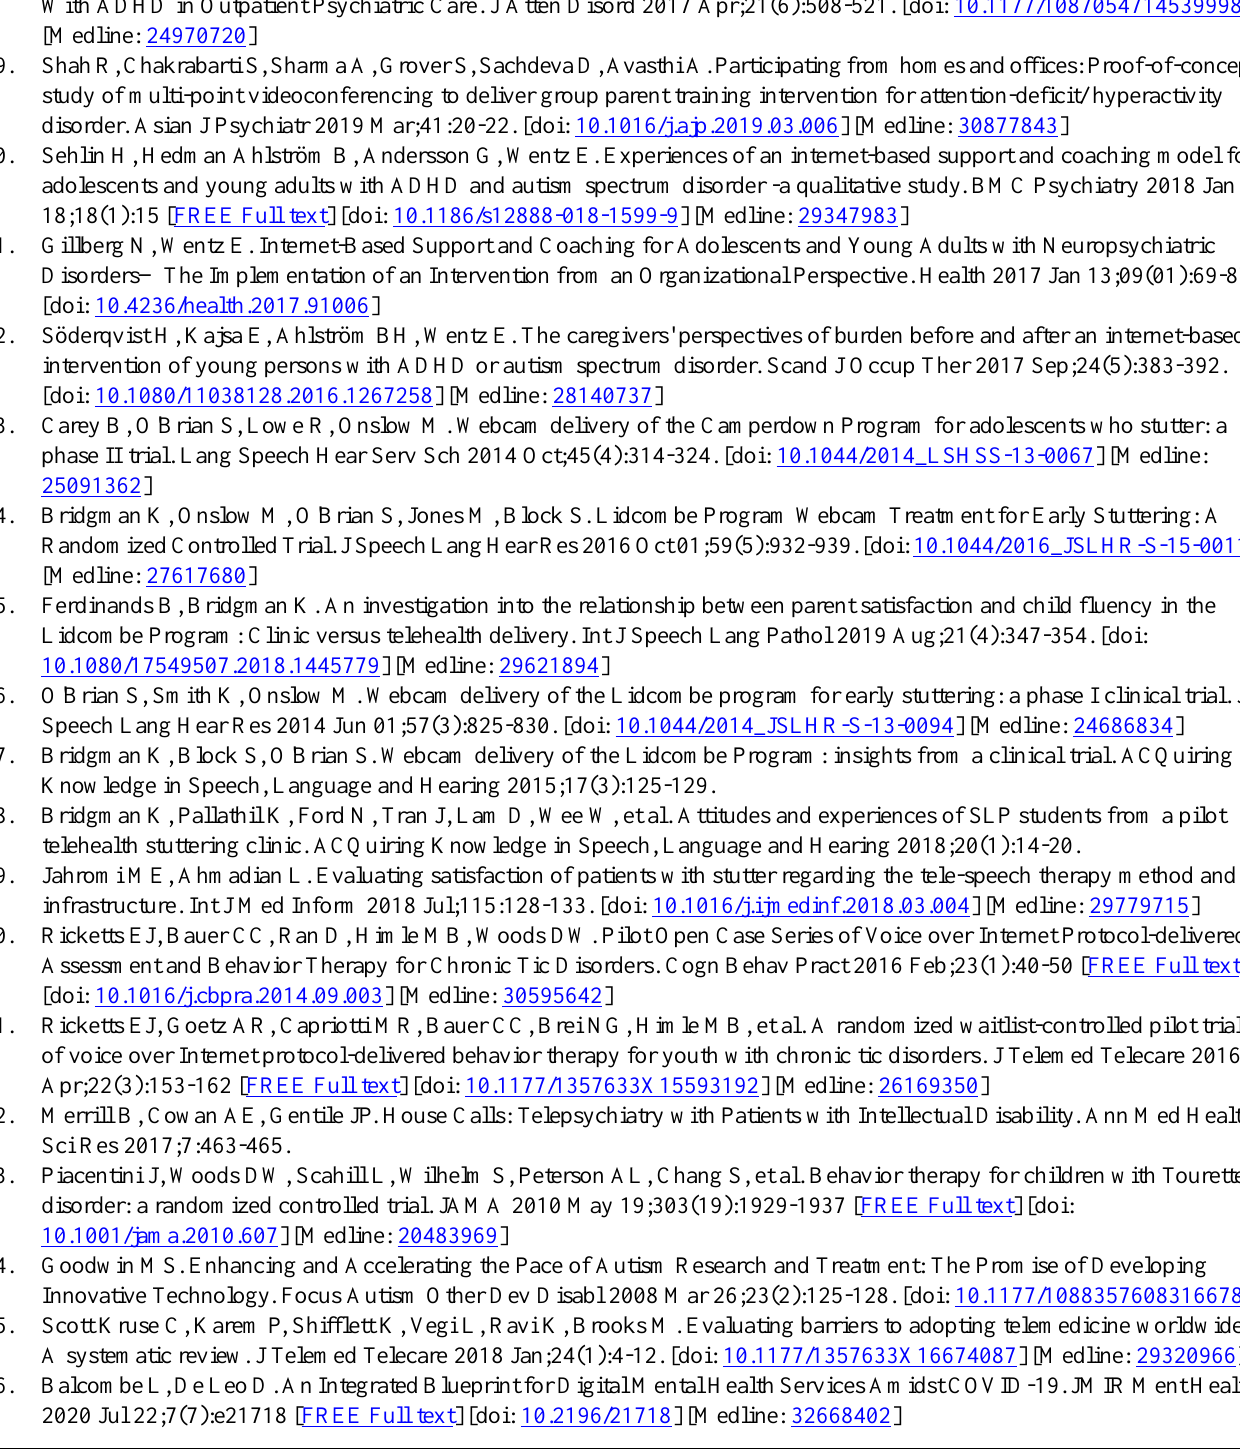
Abbreviations ADHD: attention deficit hyperactivity disorder ASD: autism spectrum disorder CATTS: Children’s ADHD Telemental Health Treatment Study NDD: neurodevelopmental disorder